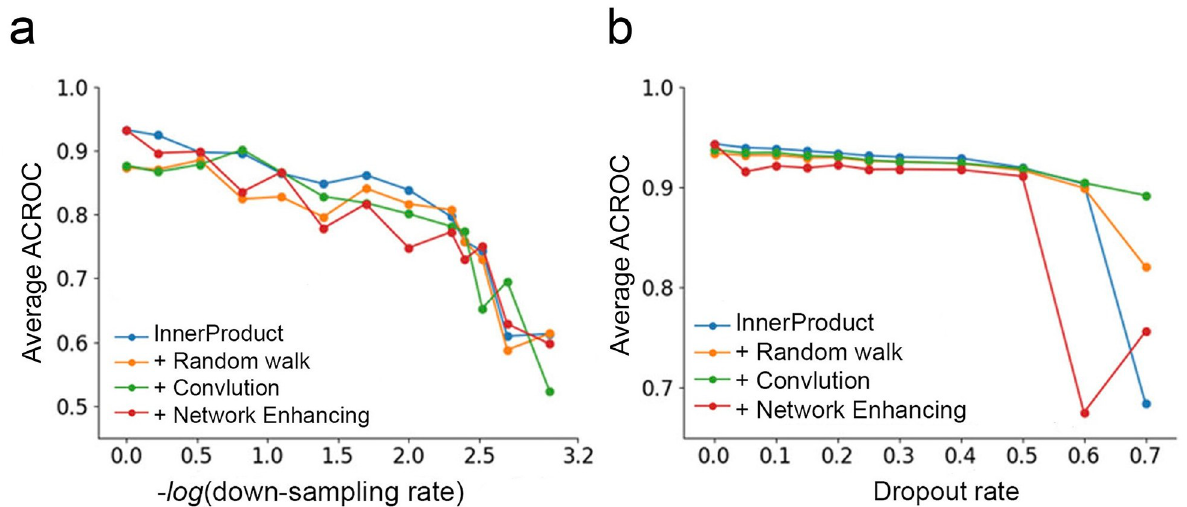
Fig 5. Average ACROC measures from InnerProduct without any smoothing, InnerProduct with random walk smoothing, InnerProduct with linear convolution, and InnerProduct with network enhancing. (a) When the dataset was sparsified with the first sparsification method, ACROC measures from the four approaches decreased when down-sampling rate increased. (b) When the dataset was sparsified with the second sparsification method, ACROC measures from the four approaches decreased when down-sampling rate increased, but at a high dropout rate (0.7), linear convolution’s ACROC remained high, whereas other methods’ ACROC dropped to below 0.9.